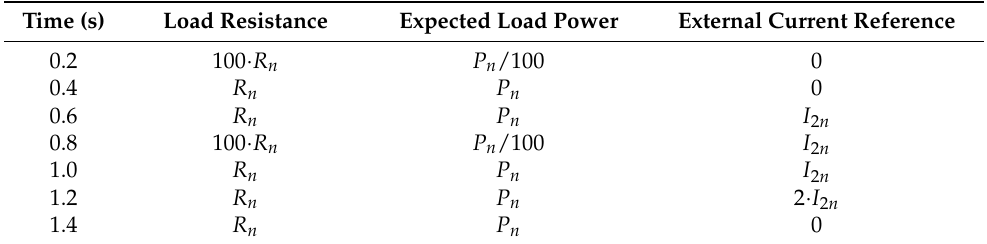
Table 3. Transitions considered in the baseline scenario and scenarios #1 (SS-GN) and #2 (SD-GN). Time